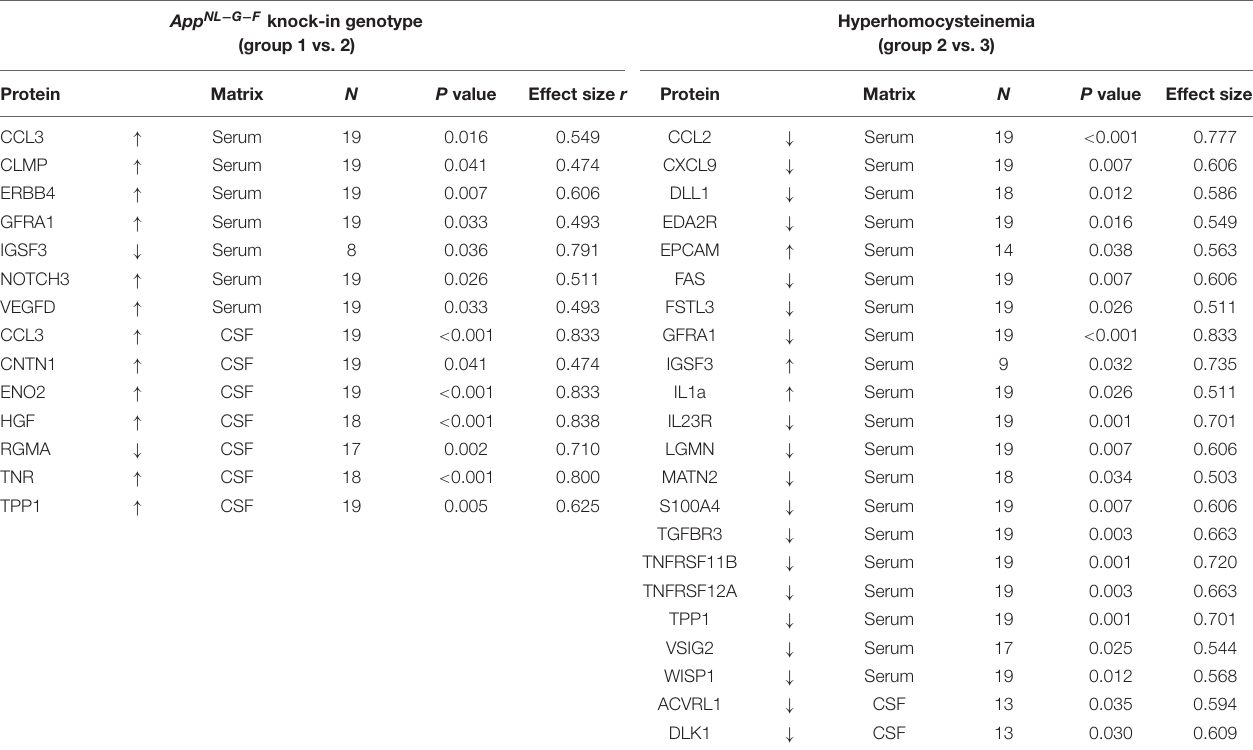
TABLE 2 | Impact of the AD-like genotype and HHCys on proteins that were found to be significantly up- or downregulated in the Olink proteomics analysis; effect size √ was calculated as | r | = z / N . App NL − G − F knock-in genotype (group 1 vs.